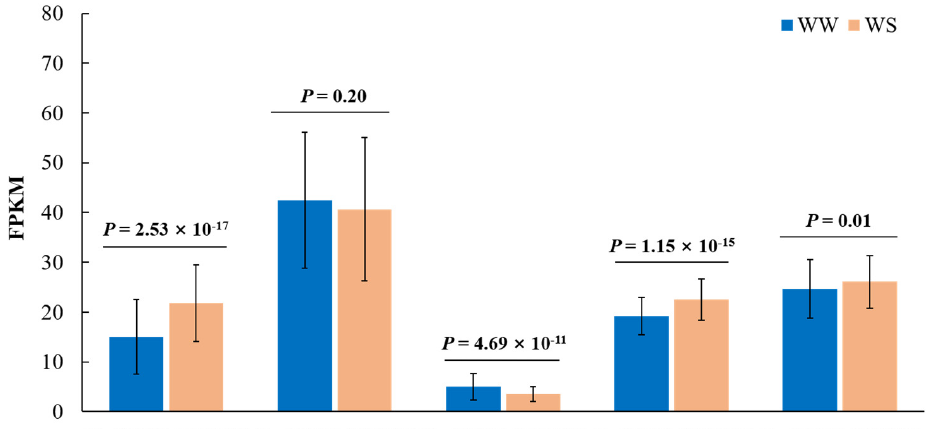
Figure 6. Drought responsive pattern of candidate genes under WS and WW conditions.